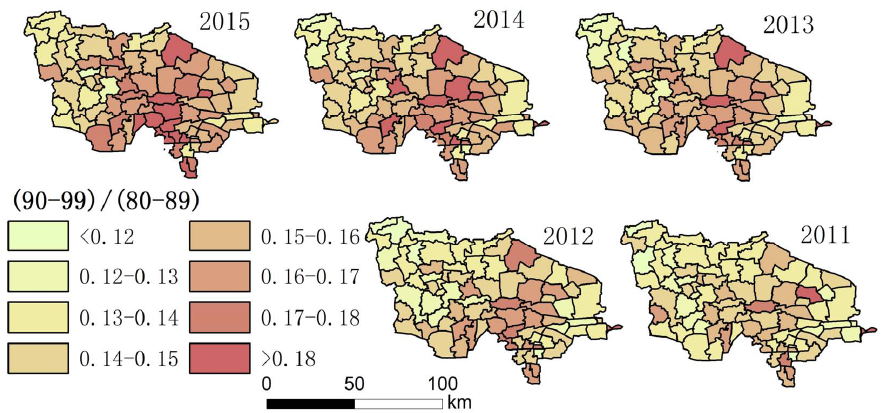
Figure 5. The proportion of the population aged 90–99 in comparison with those aged 80–89 in each town.